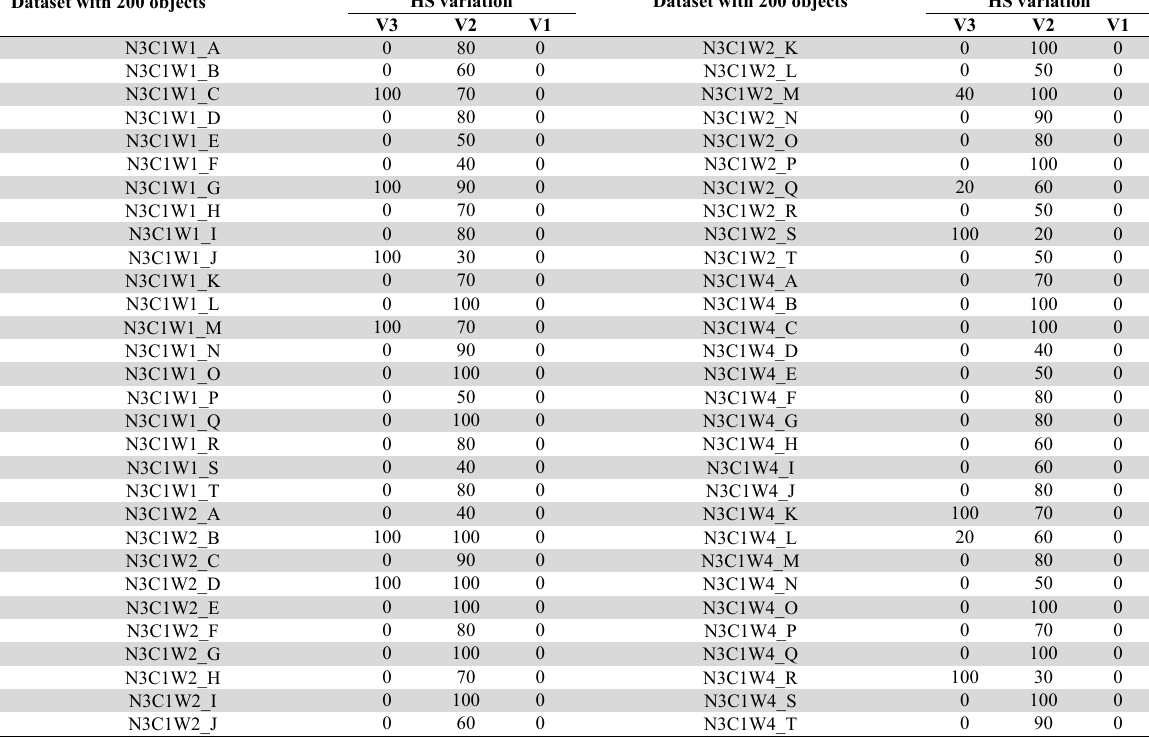
Success rate of proposed HS variations for 60 instances with 200 objects Dataset with 200 objects HS variation Dataset with 200